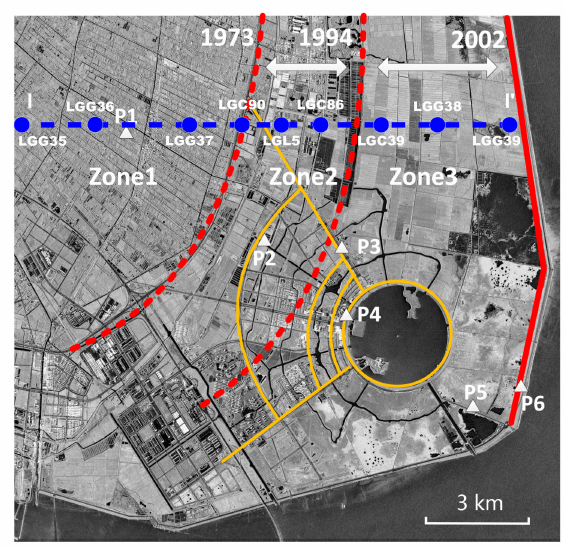
Figure 6. Partition diagram of LNC, zone1 formed before 1973, zone 2 formed between 1973 and 1994, and zone 3 formed after